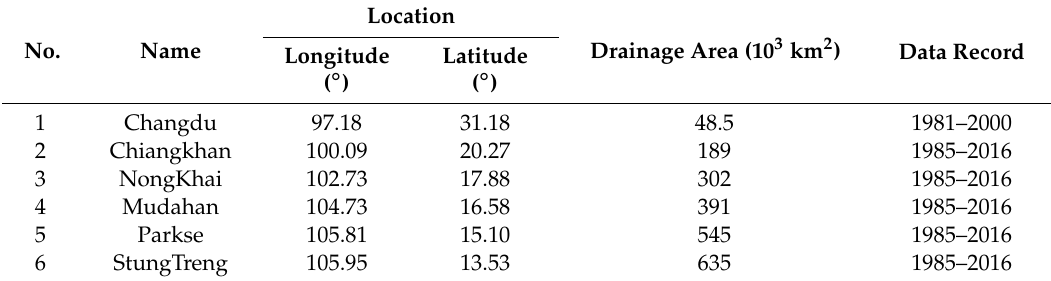
Table 1. The six hydrological gauging